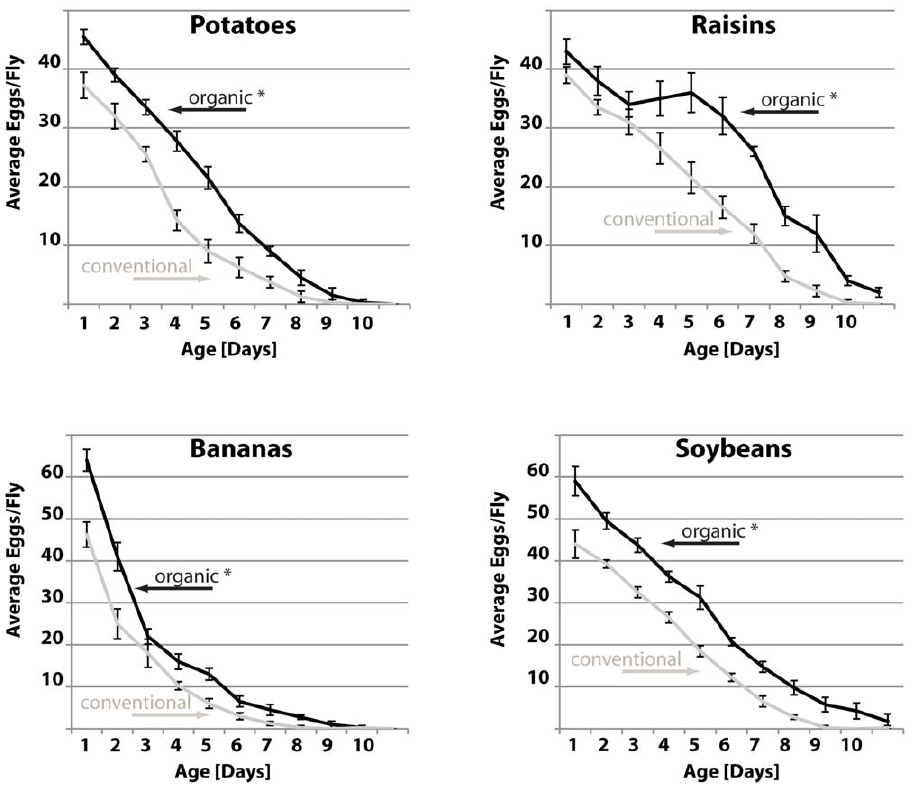
Figure 2. Daily egg-laying of flies exposed to organic diets. Egg production of flies fed the indicated food was determined daily. Shown are the averages of four biological replicates; error bars represent the standard deviation (grey: conventional food; black: organic food; statistically significant changes (p , 0.005) are indicated by asterisks; p , 0.0001 for all food types).